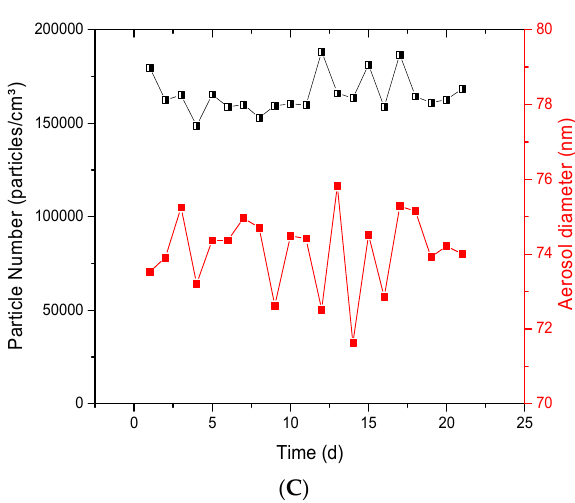
Figure 4. Evaluation of aerosols generated with the electrospray generator: ( A ) size distribution of typical TiO2 aerosols as function of mass concentration; ( B ) stability of aerosols over 6 h; ( C ) long-term stability of the number of particles and diameter in the aerosols over 21 days. The TiO2 (20 nm) suspension concentration of 100 mg/ml was used at a rate of 5, 25 and 35 μ L/min in ( A ); 6, 12 and 25 μ L/min in ( B ); 6 μ L/min in ( C ) to generate an aerosol per day over 21 days. The red points represent diameters of particles in the aerosol (nm) monitored at specific time points over 21 days (see right ordinal axis).